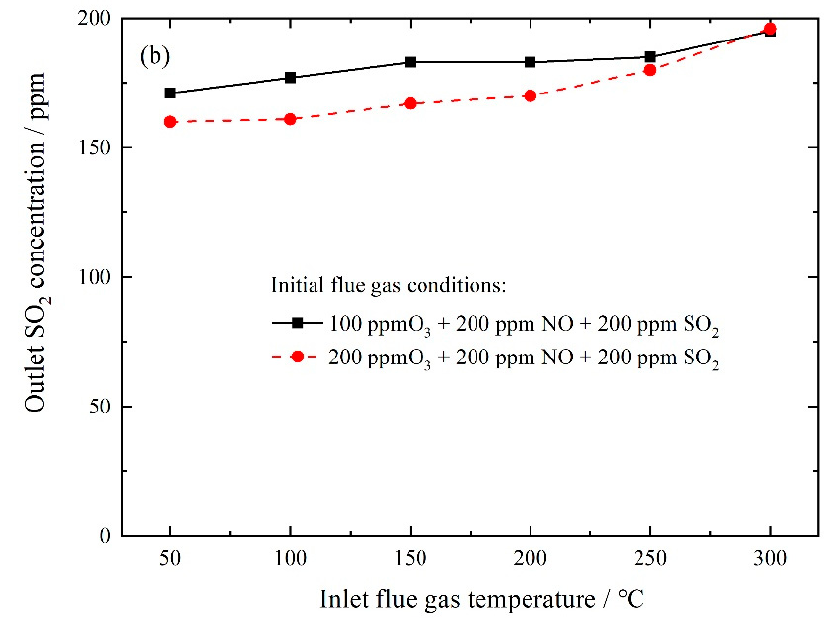
Figure 4. The e ff ects of ozone injection on ( a ) NO conversion e ffi ciencies and ( b ) outlet Figure 4. The effects of ozone injection on ( a ) NO conversion efficiencies and ( b ) outlet SO 2 SO 2 concentrations.